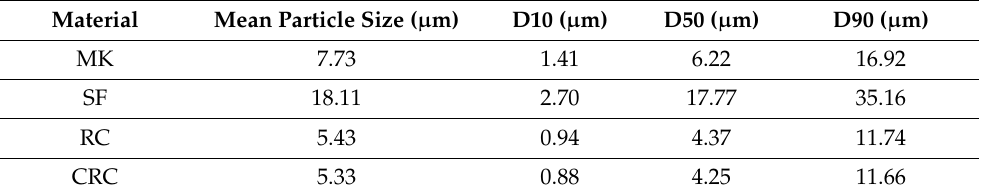
Table 4. The physical characteristics of the